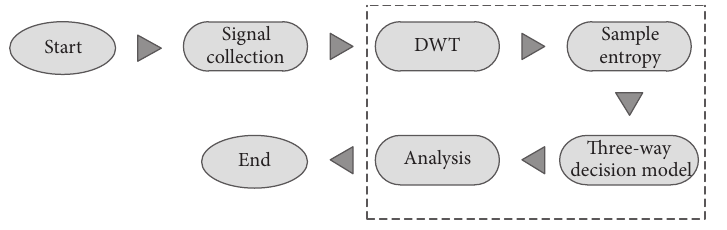
Figure 2: Overall EEG signals analysis procedure.